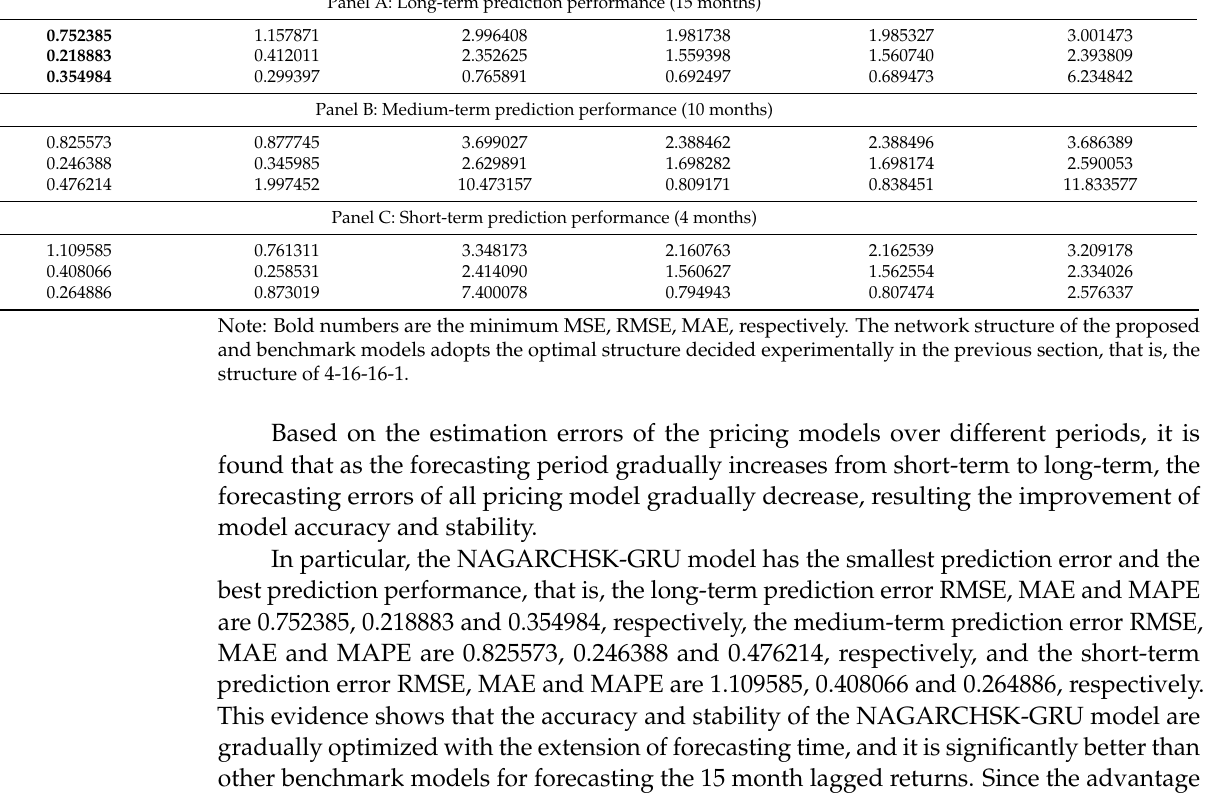
Panel B: Medium-term prediction performance (10 months)